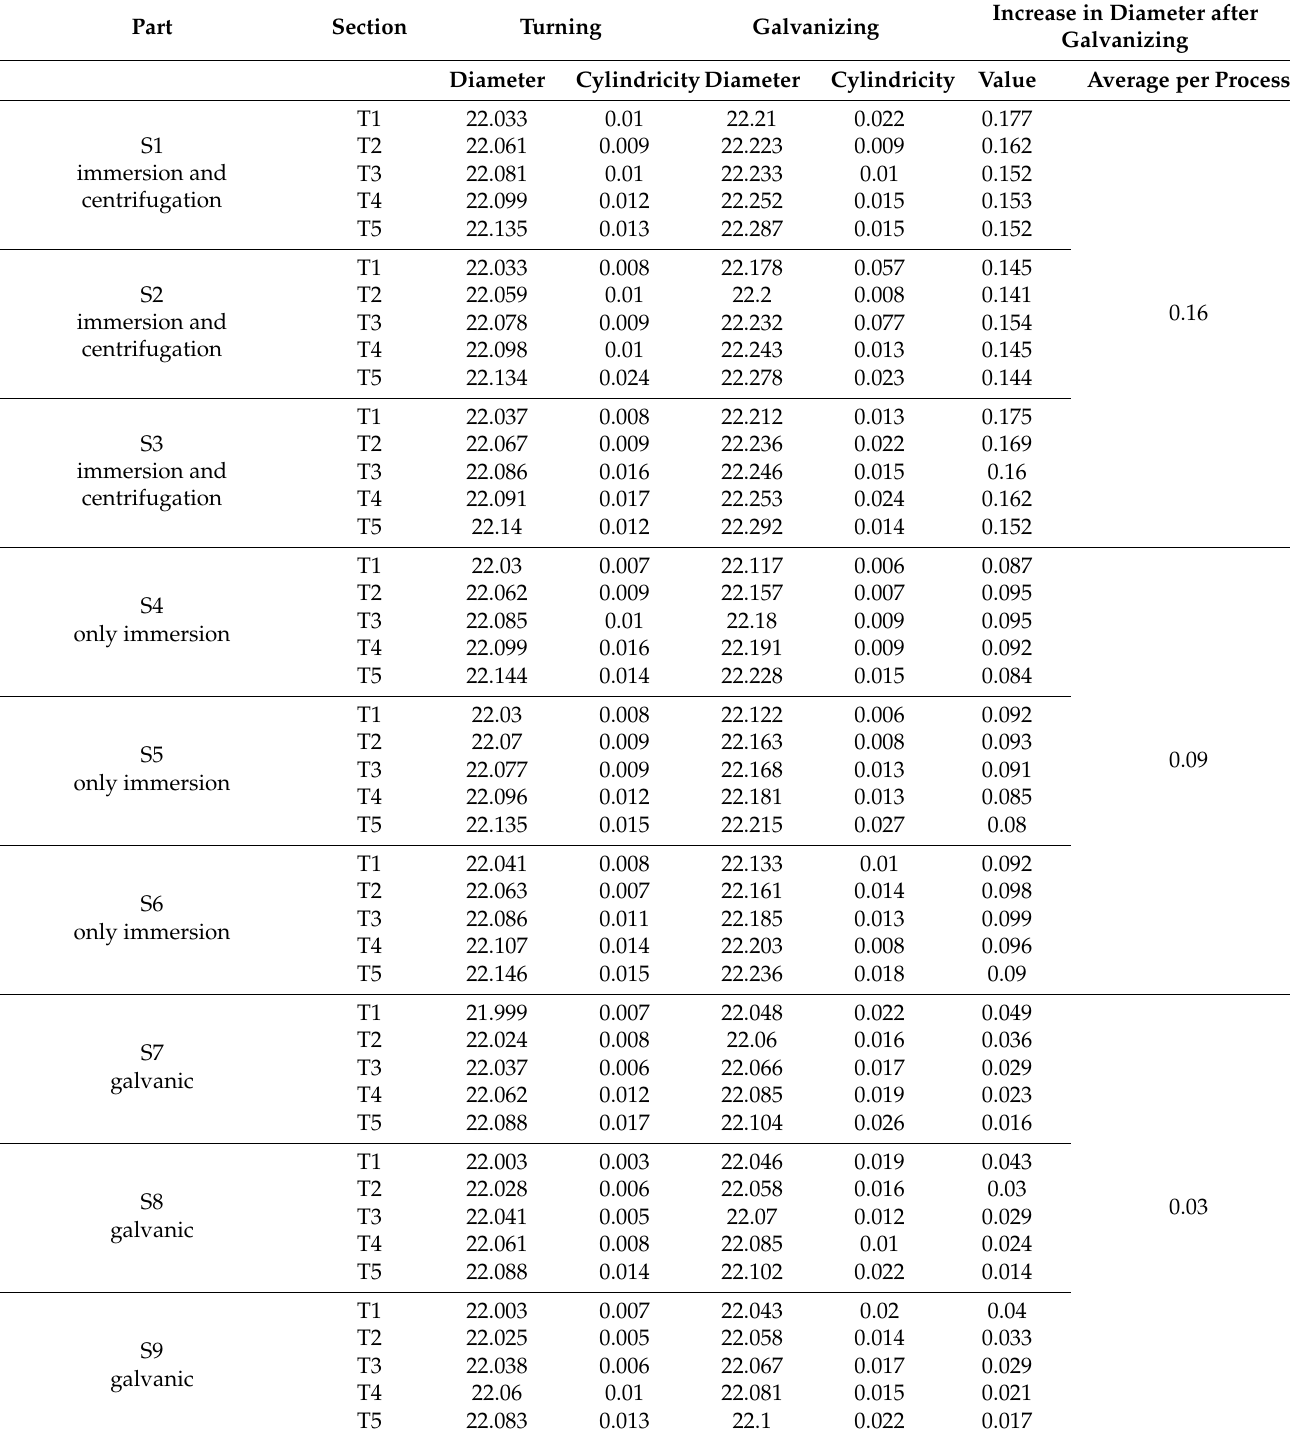
Table 12. Centralization of the measured values of the section diameters and deviations from cylindricity on the 9